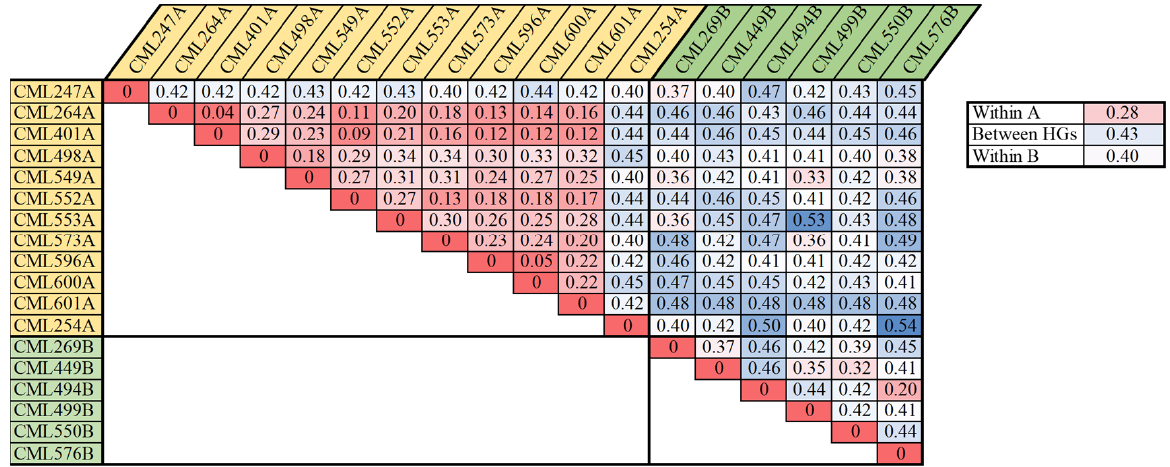
Figure 6. Heat map of the pairwise genetic distances between the 18 key founder CMLs of the Lowland tropical-Mexico (LLT) breeding program, 11 CMLs belonging to Heterotic Group “A”, and 7 CMLs belonging to Heterotic Group “B”.